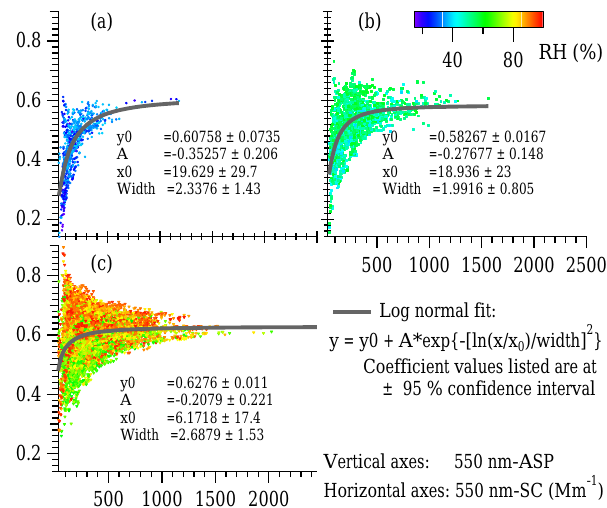
Figure 7. Relationships between the 550nm ASP and SC in differ- ent RH levels.